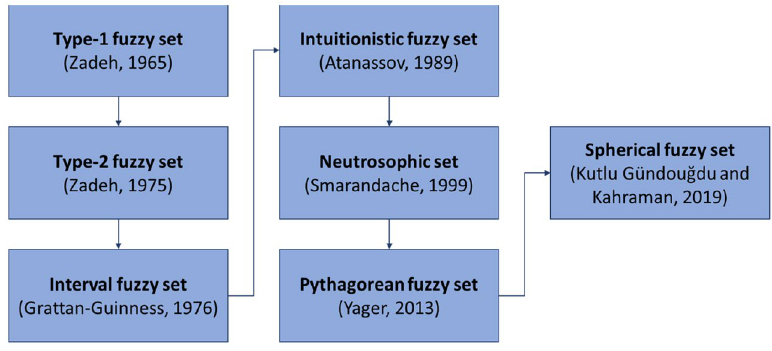
Figure 1. The historical mapping of extensions of fuzzy